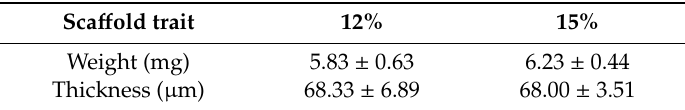
Table 3. Weight and thickness of 12% and 15% PLA scaffolds.